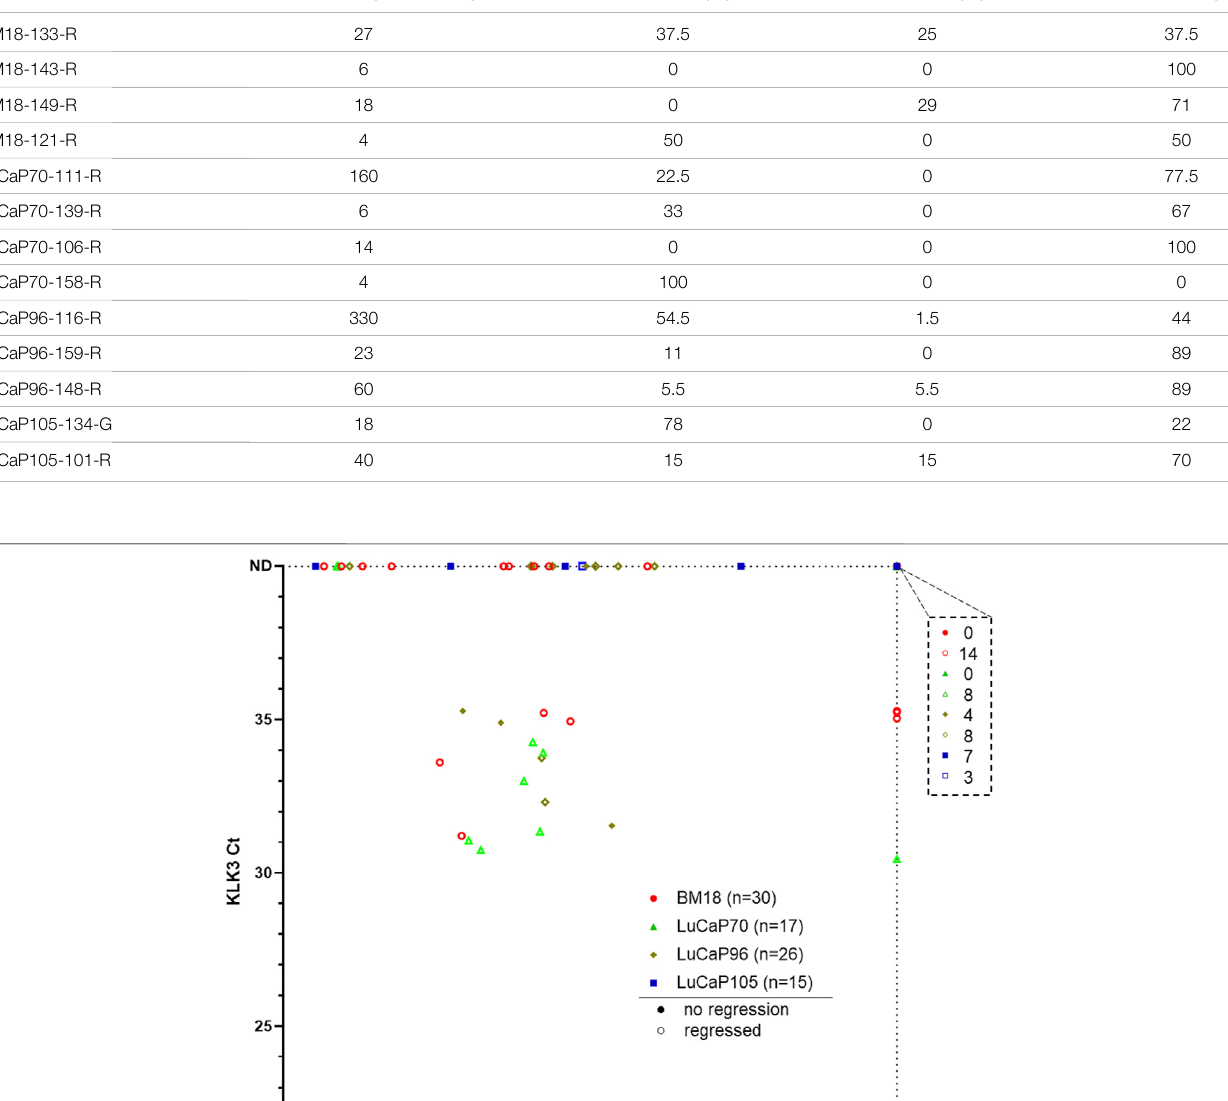
TABLE 2 | CTC cluster counts in castrated PDX blood samples using cytokeratin/vimentin (KRT/VIM) immuno fl uorescence staining. PDX ID Total Clusters (Clusters/ml)